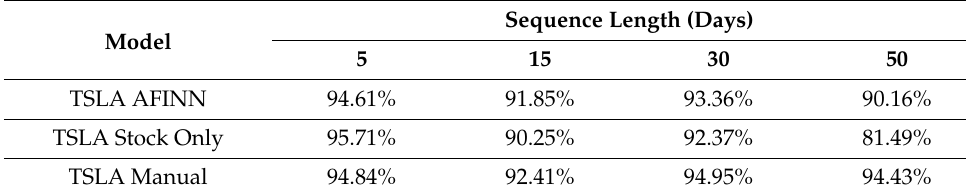
Table 10. Comparison of Sequence